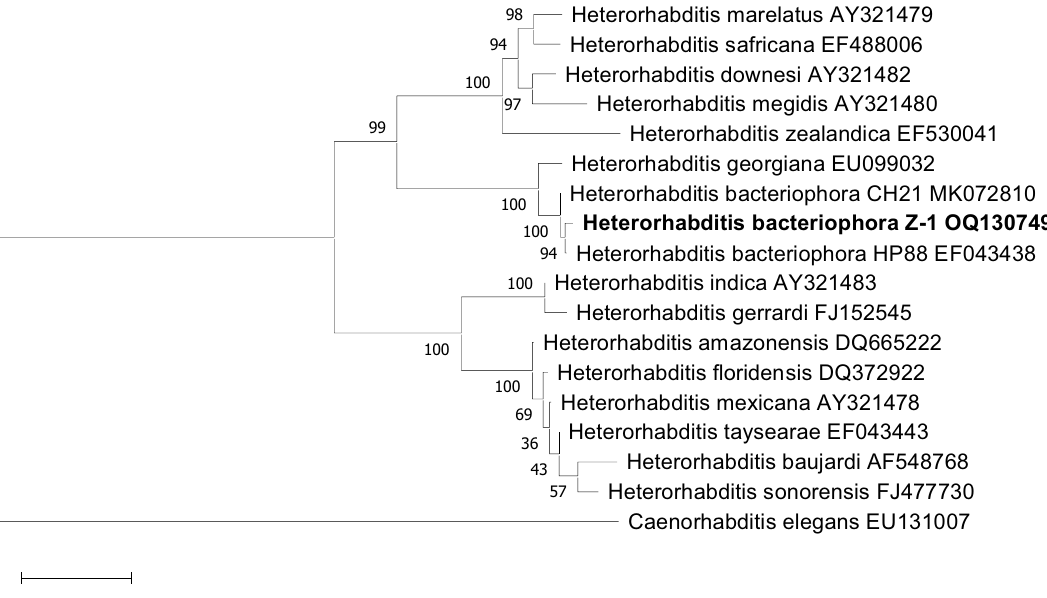
Fig. 1 Phylogenetic relationships of the species used in the study and other related species of Heterorhabditis based on analysis of ITS rDNA regions. Caenorhabditis elegans was used as outgroup taxon. The percentage of replicate trees in which the associated taxa clustered together in the bootstrap test (10,000 replicates) are shown next to the branches. Branch lengths indicate evolutionary distances and are expressed in the units of number of base differences per